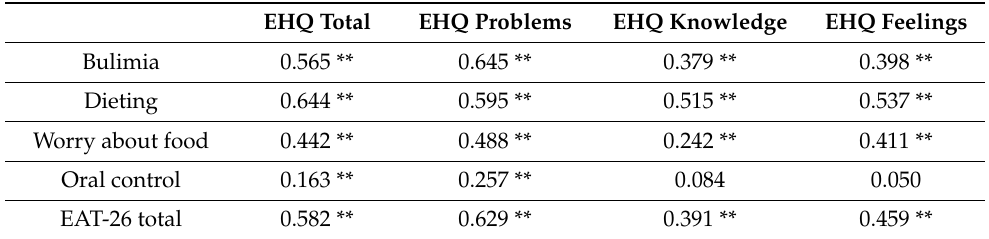
Table 3. Correlations of the EHQ and its dimension with the EAT-26 dimensions. EHQ Total EHQ Problems EHQ Knowledge EHQ Feelings Bulimia 0.565